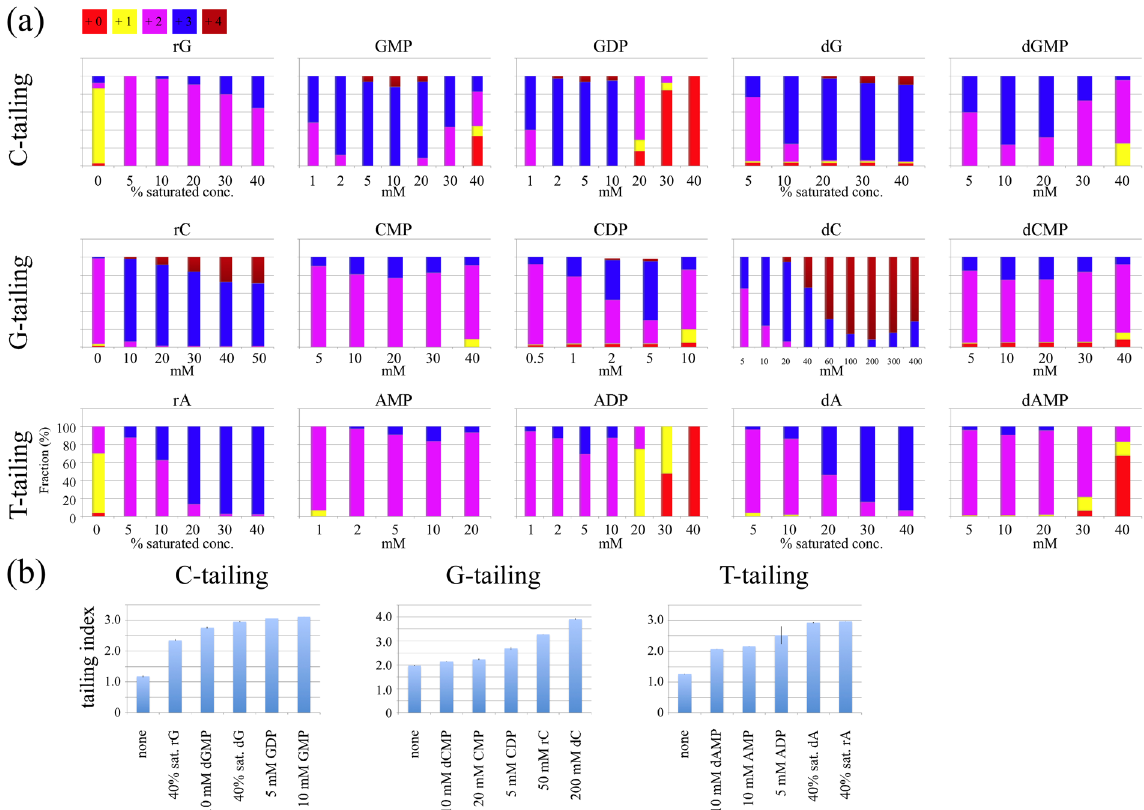
Figure 2. Optimal concentration of compounds that enhance MMLV-RT tailing activity. ( a ) Tailing reactions were conducted in the presence of each compound at different concentrations. Results are shown as averages of triplicate experiments. For dA, rA, dG, and rG, concentrations are shown as the % saturated concentrations, which were measured in TE buffer at 25 °C and were 50 mM, 25 mM, 13 mM, and 2 mM, respectively. ( b ) Tailing index values were calculated from the results at the optimal concentration shown in ( a ).